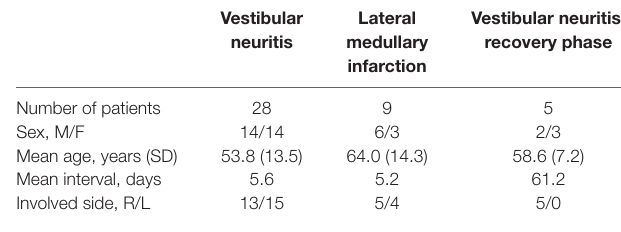
TaBle 1 | Demographic and clinical data of the patients with vestibular